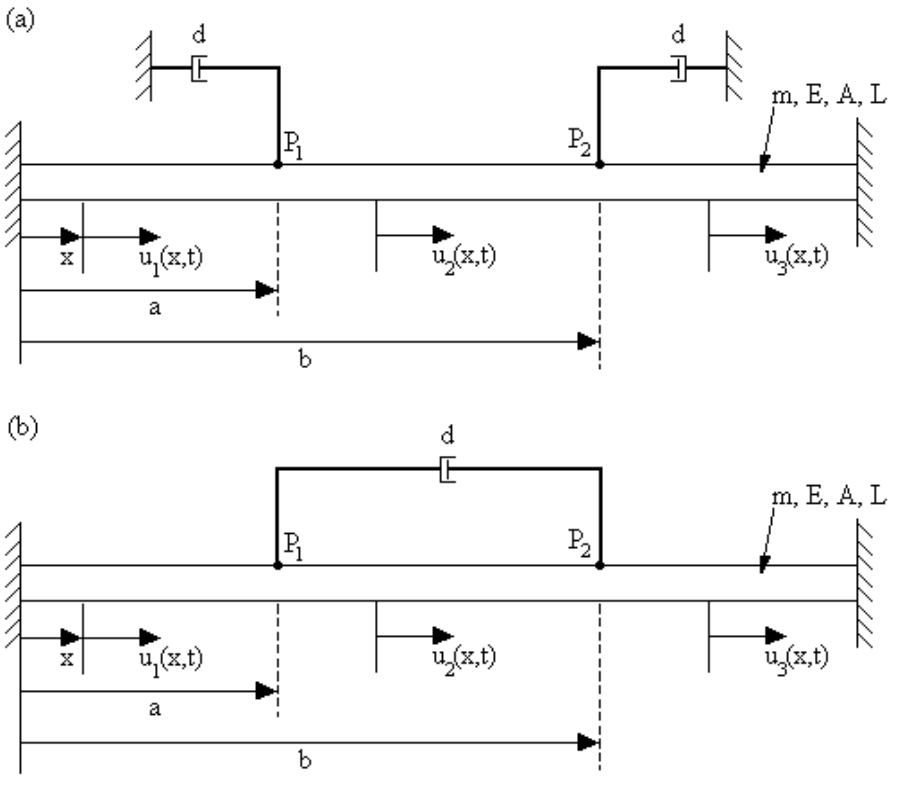
Fig. 1. Longitudinally vibrating elastic rods with (a) locally reacting damping and (b) non-locally reacting